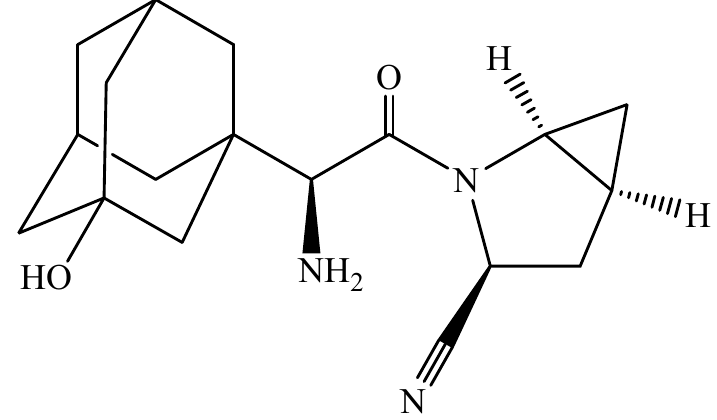
Figure 1. Chemical structure of Saxagliptin. Saxagliptin is currently available in a 2.5 mg dose with poor membrane permeability that ultimately results in lesser oral bioavailability of up to 50%. Its solubility in the water further leads to a short elimination half-life (4–6 h), hence demanding multiple daily dosing. Moreover, the uncontrolled release from conventional tablets and higher systemic concen- trations of Saxagliptin leads to gastrointestinal disturbances such as diarrhea, stomach pain, vomiting, bloating, and nausea. Furthermore, it is also a substrate for the P-glycoprotein- driven efflux that also contributes to the rapid removal of the drug [16]. Thus, a controlled release dosage form may prove to be a good choice to solve the aforementioned drug problem and may enhance the patient’s